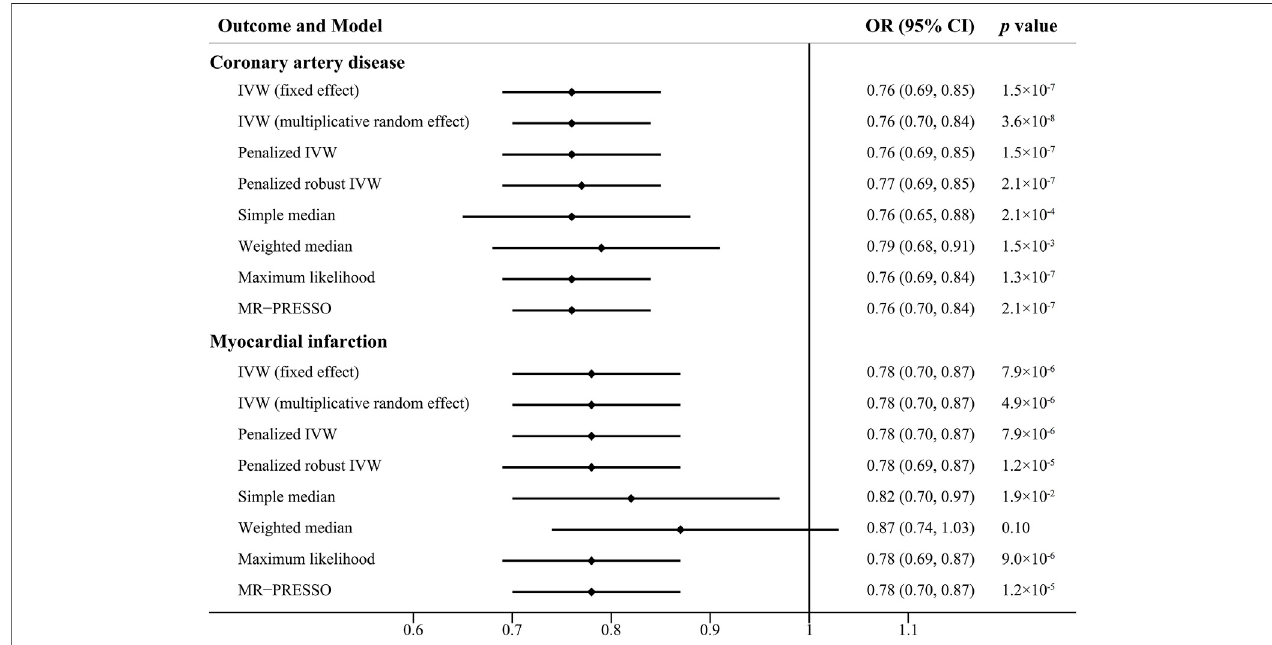
FIGURE2 | Causal effectestimates ofgeneticallypredicted intelligenceon coronary arterydisease and myocardialinfarctionusing different statistical models. OR, odds ratio; CI, con fi dence interval.